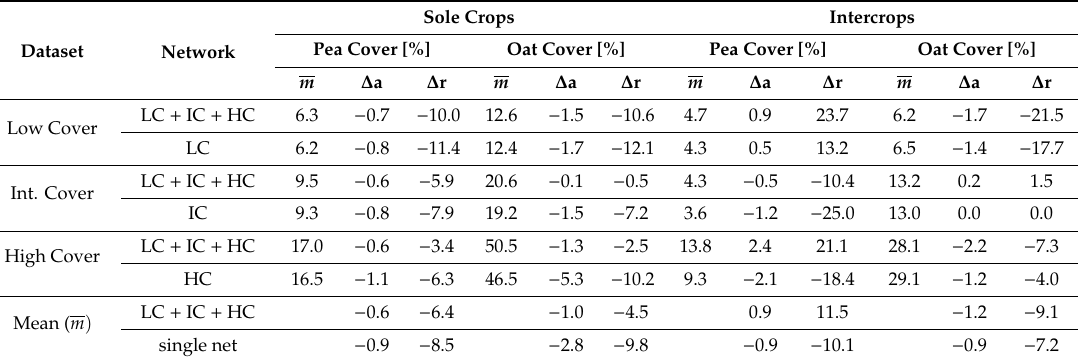
Table 5. Mean estimated canopy cover ( m ) of pea and oat in sole crops and intercrops and absolute ( ∆ a) and relative ( ∆ r) di ff erence to ground truth for the three evaluation datasets (low, intermediate, and high